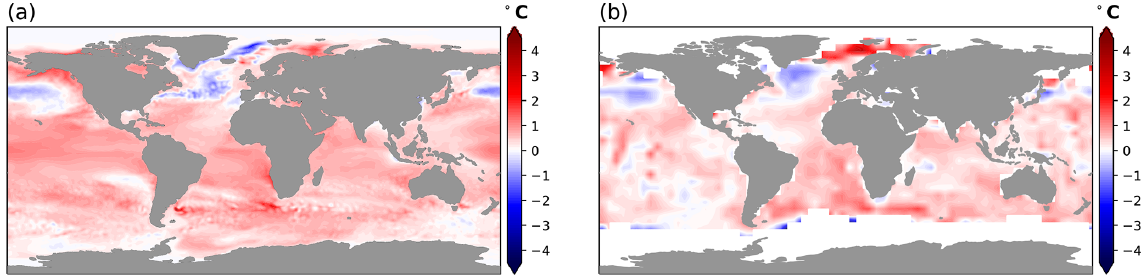
Figure 3. Sea-surface temperature (SST) warming pattern [ ◦ C] calculated (a) from ECHAM6 CMIP6 modelled data and (b) from HadSST3 observed data.